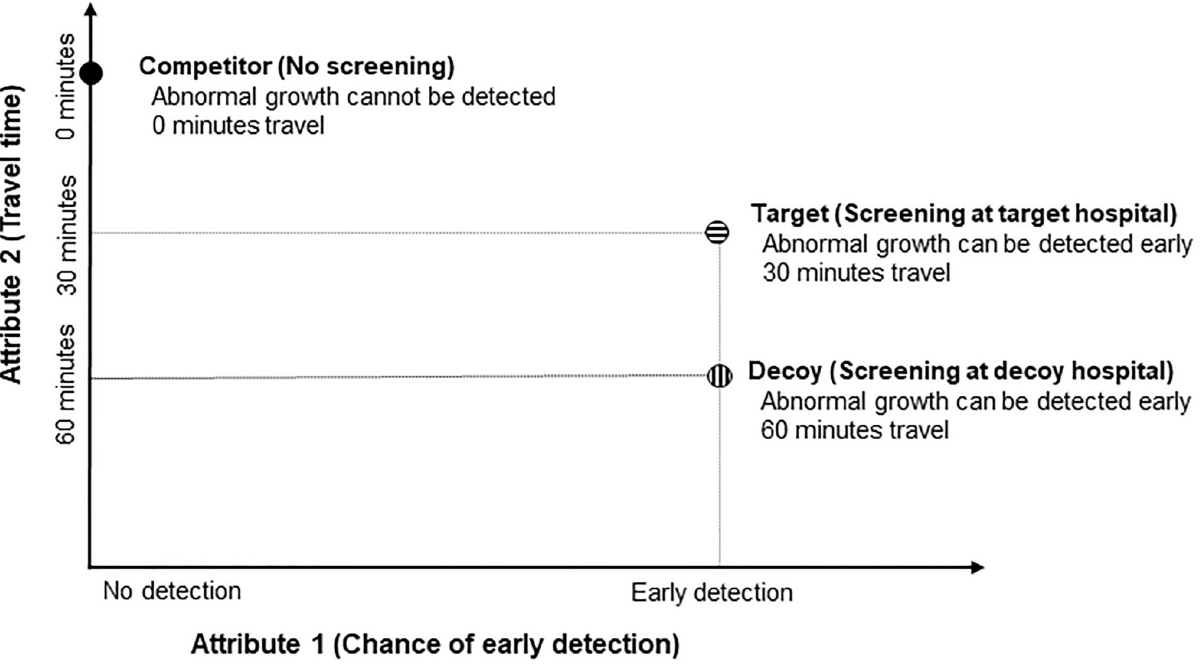
Fig 1. Implementation of the decoy effect in Study